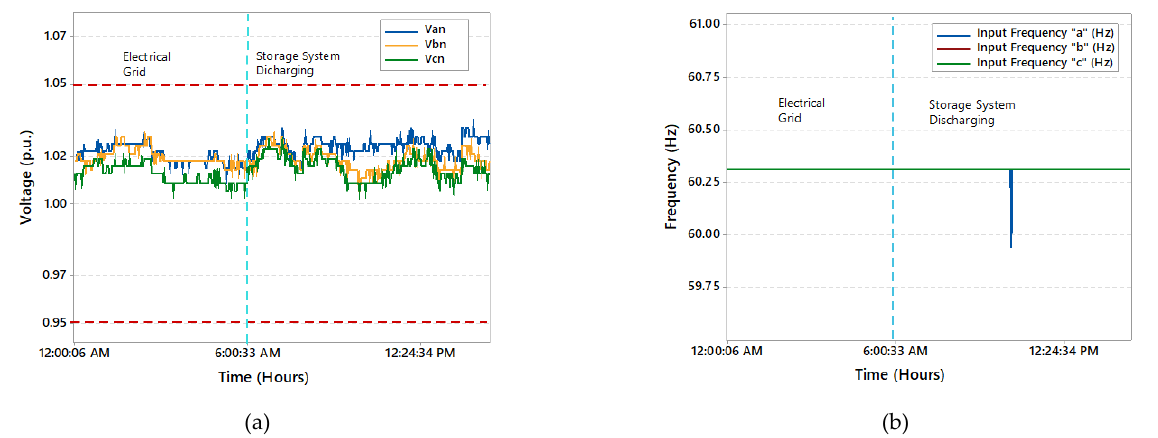
Figure 12. ( a ) voltage and ( b ) frequency variation during discharging period in storage system.